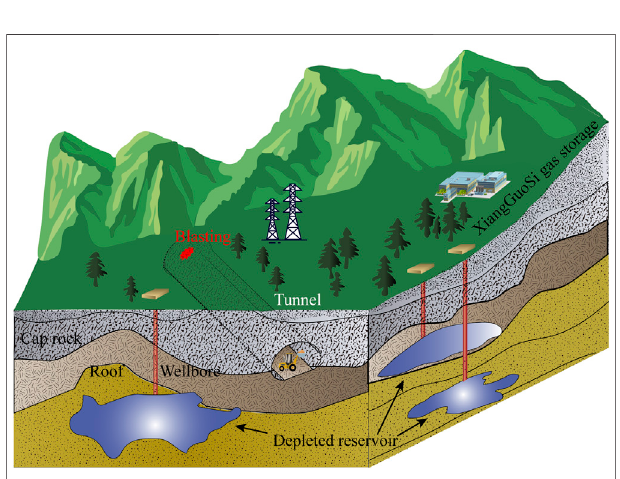
FIGURE 3 | Diagram of the spatial locations of the tunnel and gas storage.